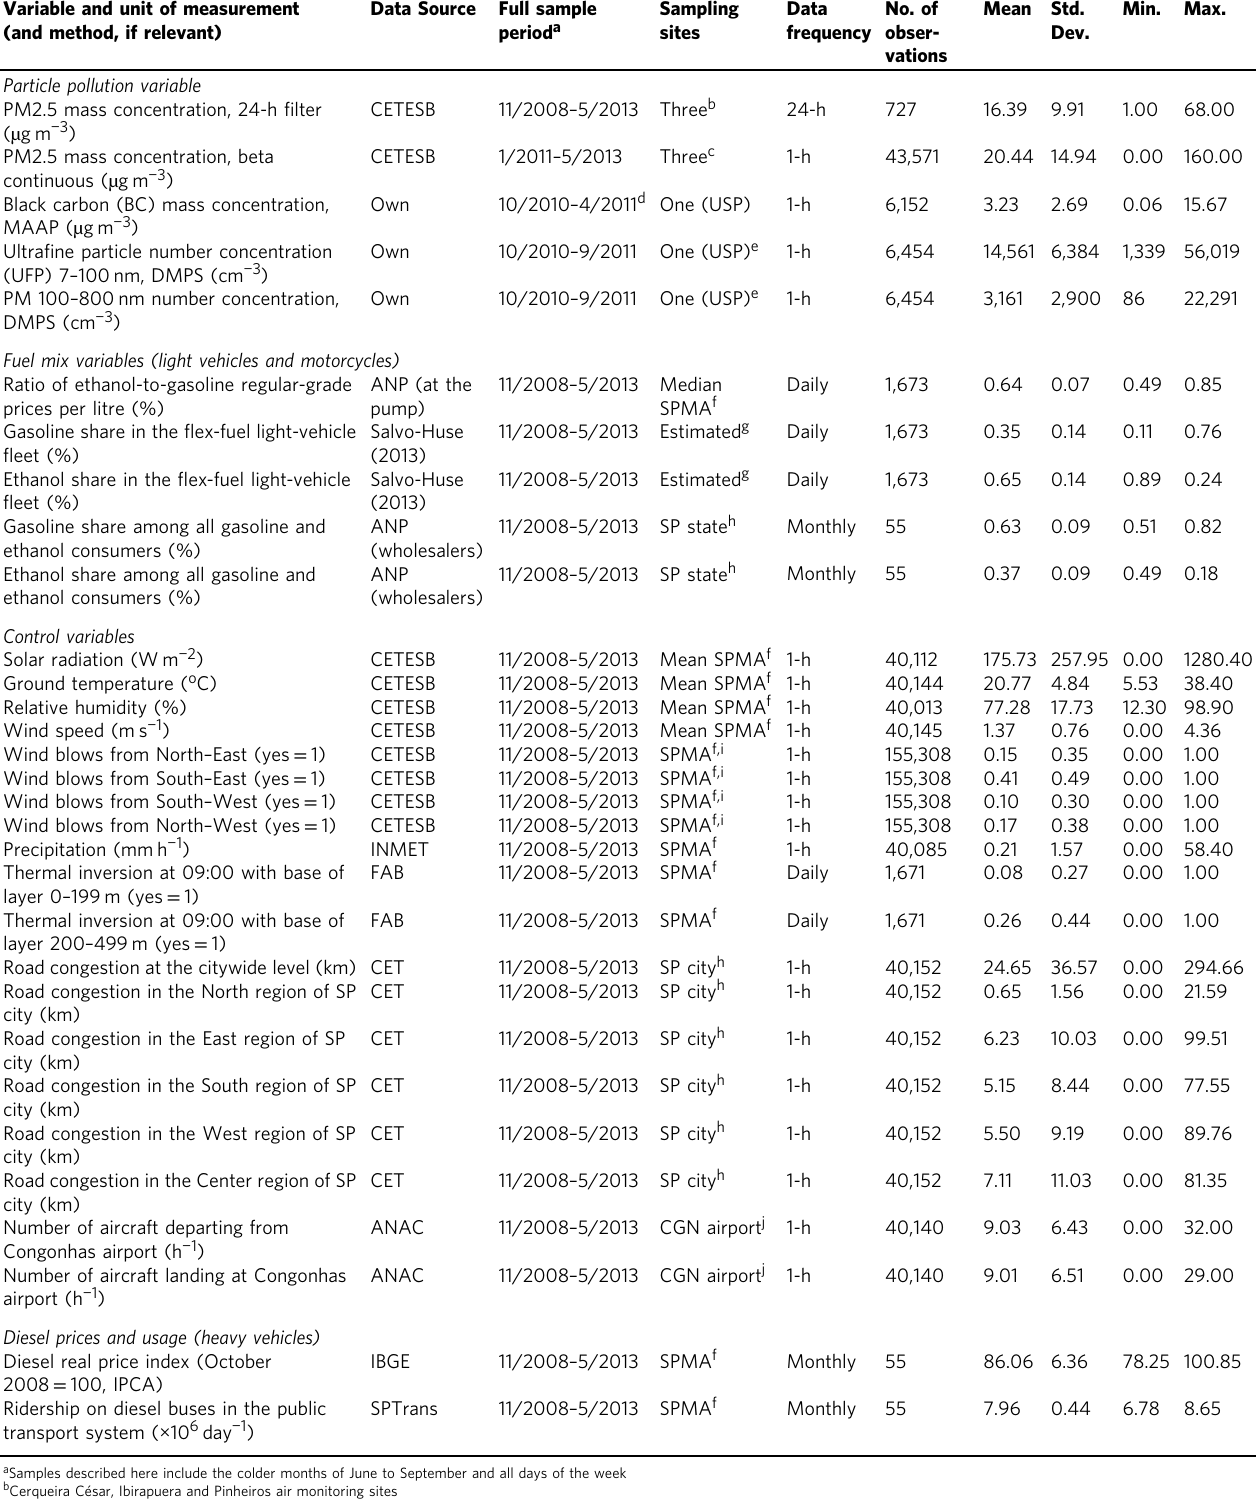
Table 1 Description of the different data sets that the present study combines including summary statistics Variable and unit of measurement (and method, if